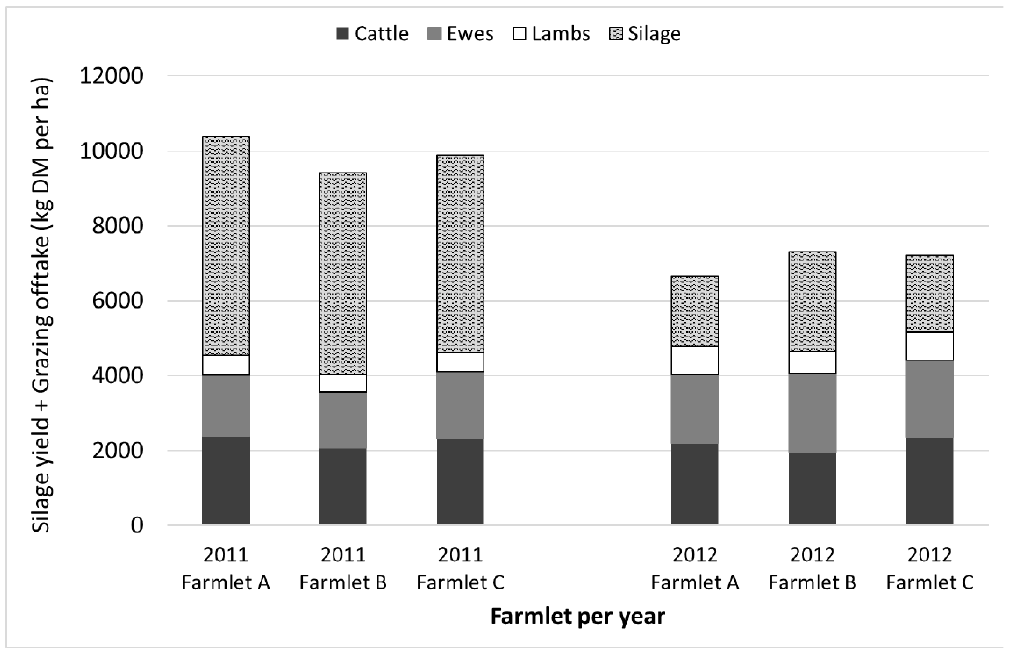
Figure 3. Silage yield plus grazing offtake (kg DM ha − 1 ) by cattle, ewes and lambs for farmlets A, B and C in 2011 and 2012.